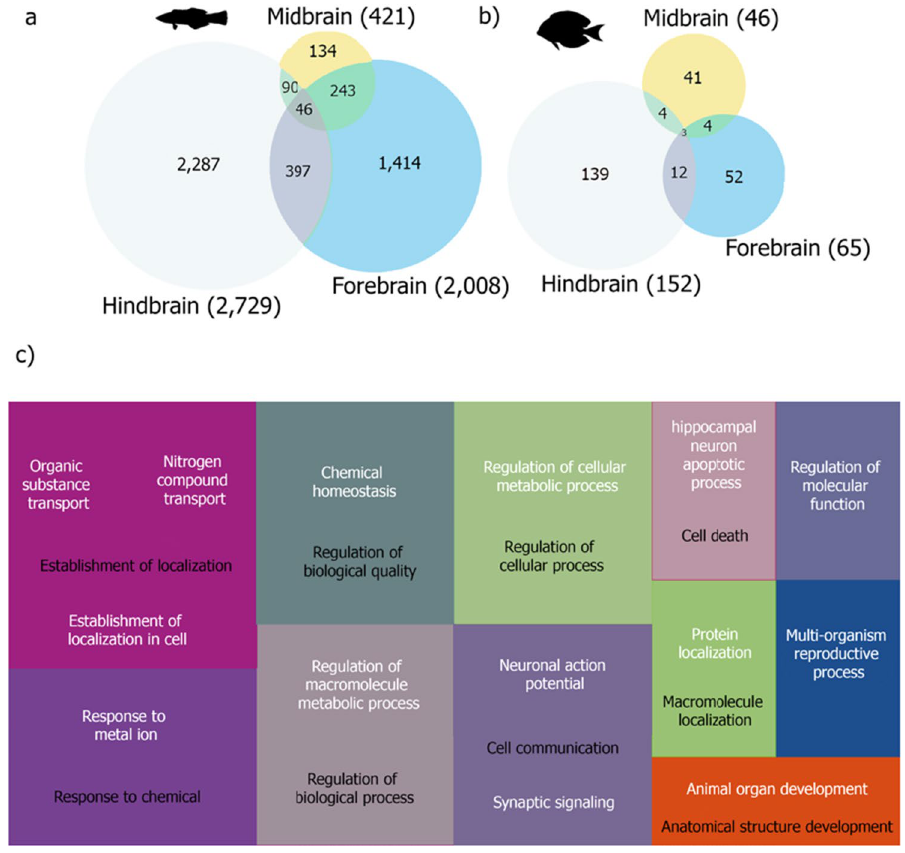
Figure 1. Number of differentially expressed genes between control and interaction for each brain region and the common overlap of ( a ) Labroides dimidiatus and ( b ) Acanthurus leucosternon . Numbers in brackets represent the total differential expressed genes found in each brain region. ( c ) Gene Ontology treemap for L. dimidiatus representing the commonly enriched functions across the three brain regions when interacting with a client. Boxes with the same colour correspond to the upper-hierarchy GO-term, and its title is found in the middle of each box. For A. leucosternon no common enriched functions were found across the three brain regions. Description of the enriched functions for both species can be found in Supplementary Tables